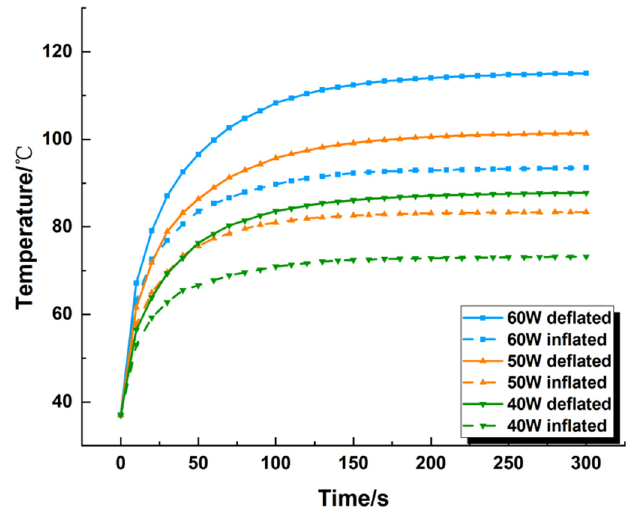
Figure 11. Temperature curve at the slot of microwave antenna.